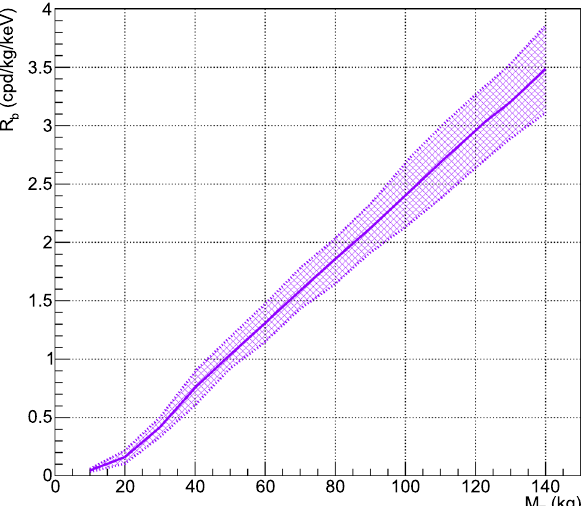
Fig. 10 Maximum background and minimum mass combinations that provide 3 σ exclusion of DAMA within three years of